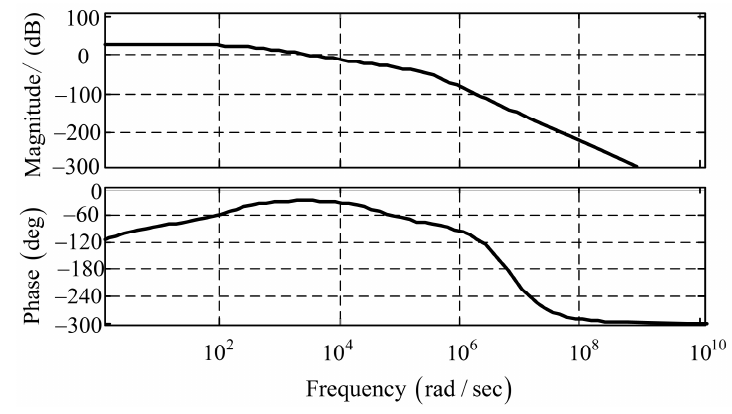
Figure 7. Bode plot of G*F.